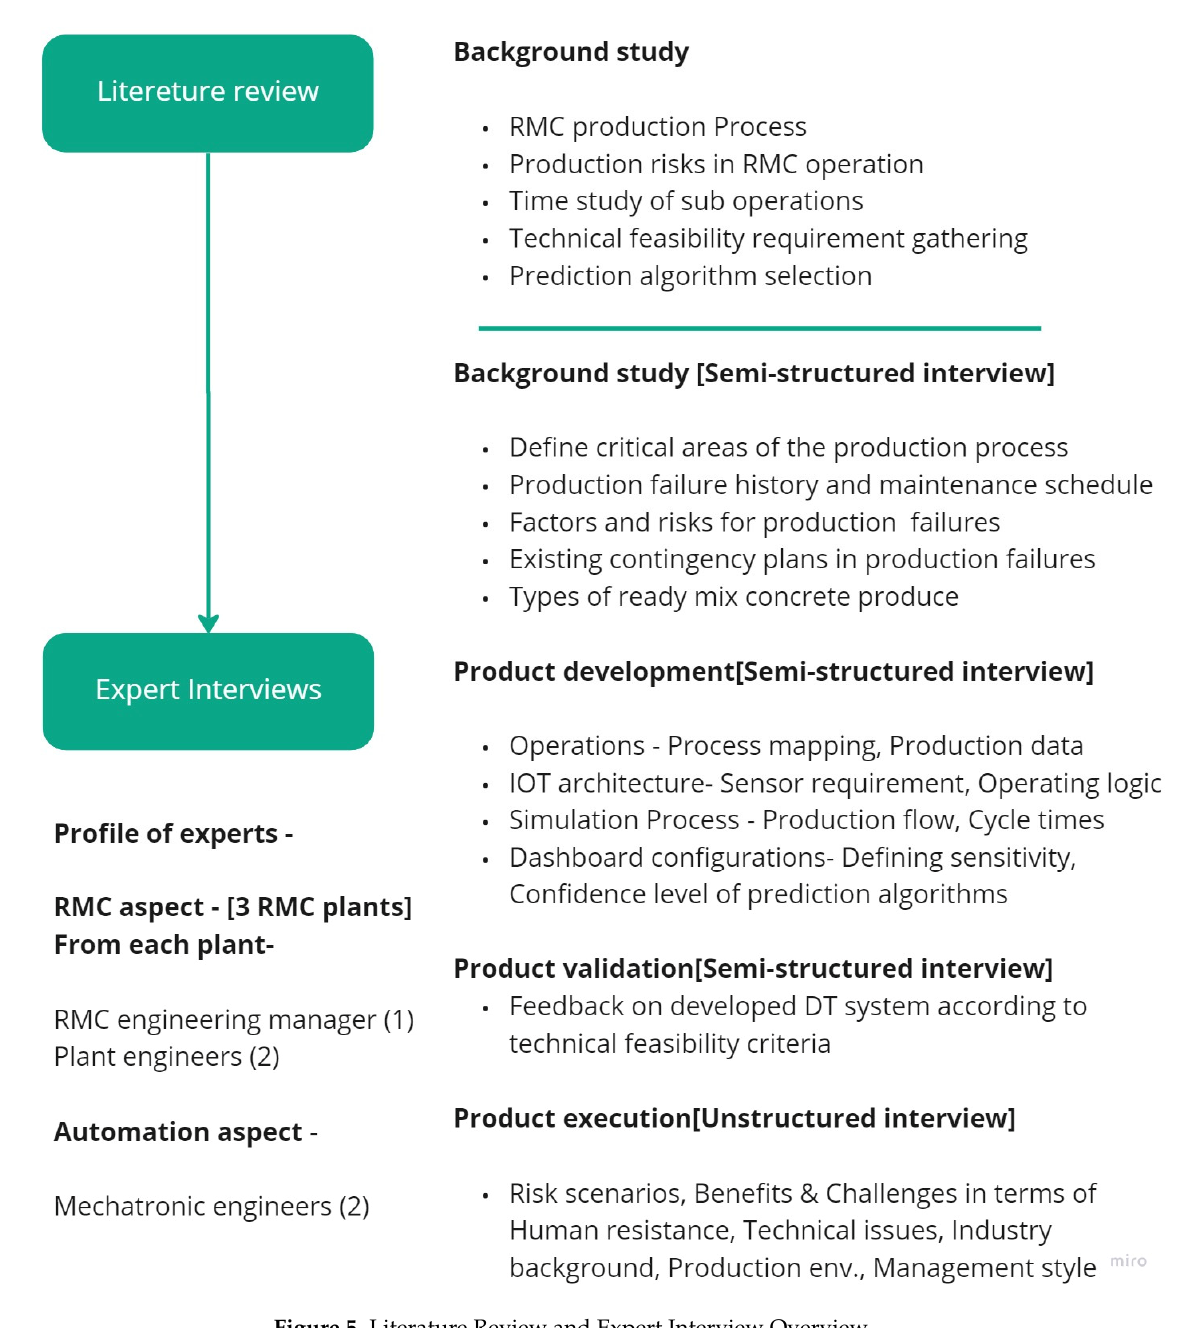
Figure 5. Literature Review and Expert Interview Overview.